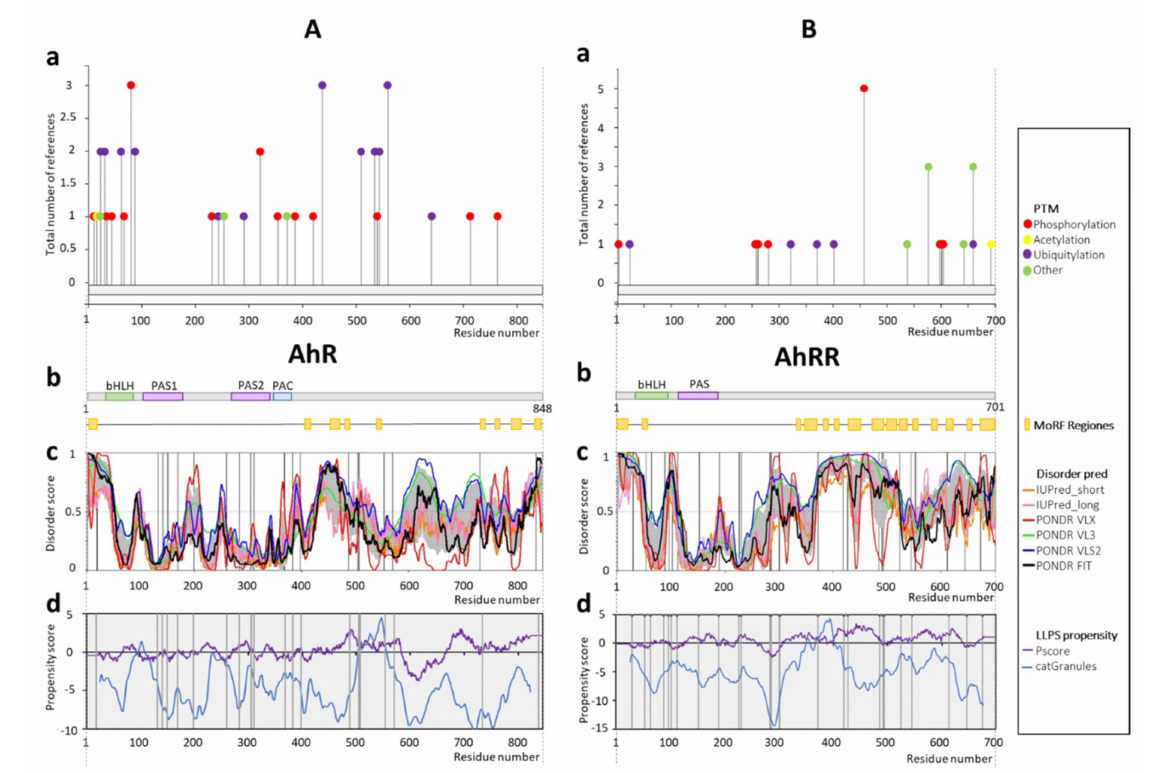
Figure 2. Schematic presentation of results for ( A ) AhR (P35869) and ( B ) AhRR (A9YTQ3) analysis. ( a ) Post-translational modifications based on PhosphoSitePlus server [99]; ( b ) the domain structure of protein: green indicates the bHLH domain (27–80aa AhR; 28–81aa AhRR), purple represents PAS domains (111–181aa PAS1, 275–342aa PAS2 AhR; 112–182aa PAS AhRR), whereas blue indicates PAC (348–386aa PAC AhR). Predicted MoRFs [100] are indicated as orange rectangles, ( c ) D 2 P 2 database disorder regions predictions based on the protein amino acids sequence (find the legend in the plot for description). Grey shadow presents the averaged disorder profile, and a score over 0.5 indicates a high probability of disorder. Positions of disease-linked mutations are marked as black vertical lines (listed in HuVarBase database [101], Supplementary Materials), ( d ) liquid–liquid phase separation (LLPS) propensity predictions based on catGranules (blue line) [102] and PScore (purple line) [103] servers; positions of disease-linked mutations are marked as black vertical lines (listed in HuVarBase database [101], Supplementary